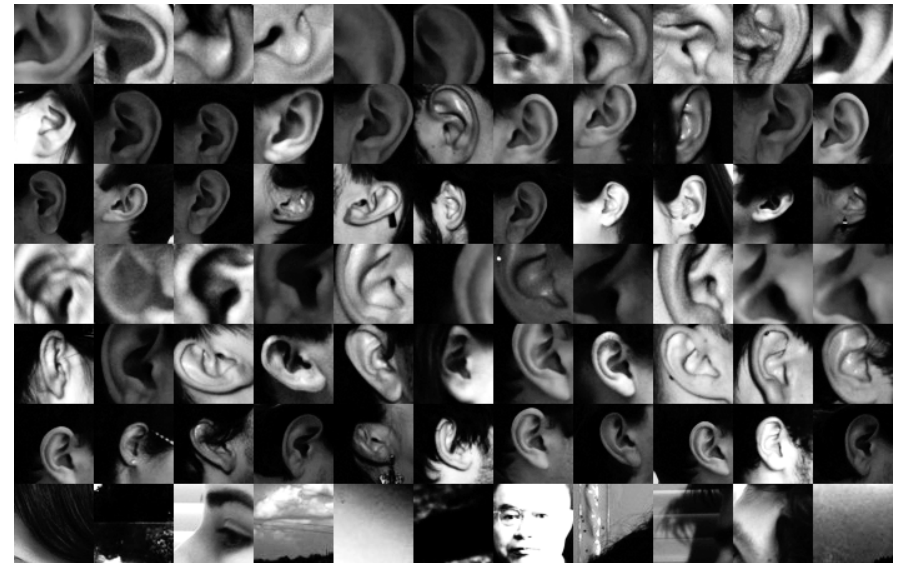
Figure 5. A small subset of each of the seven datasets used for training. From top to bottom: Left-Small, Left-Medium, Left-Large, Right-Small, Right-Medium, Right-Large,